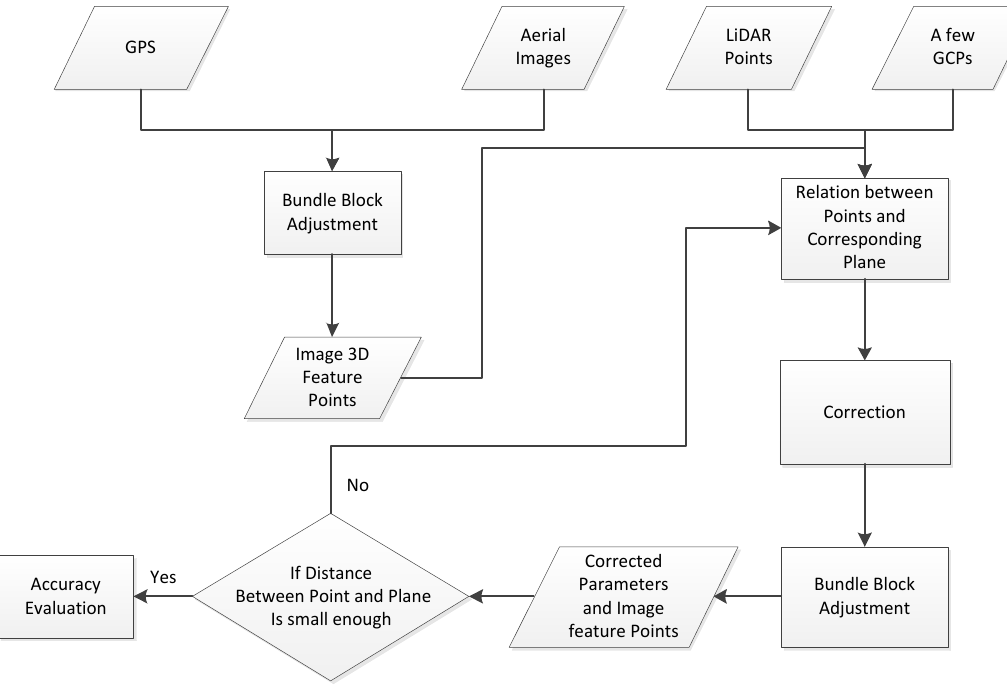
Figure 1. Flow chart of light detection and ranging (LiDAR) point cloud-assisted aerotriangulation.